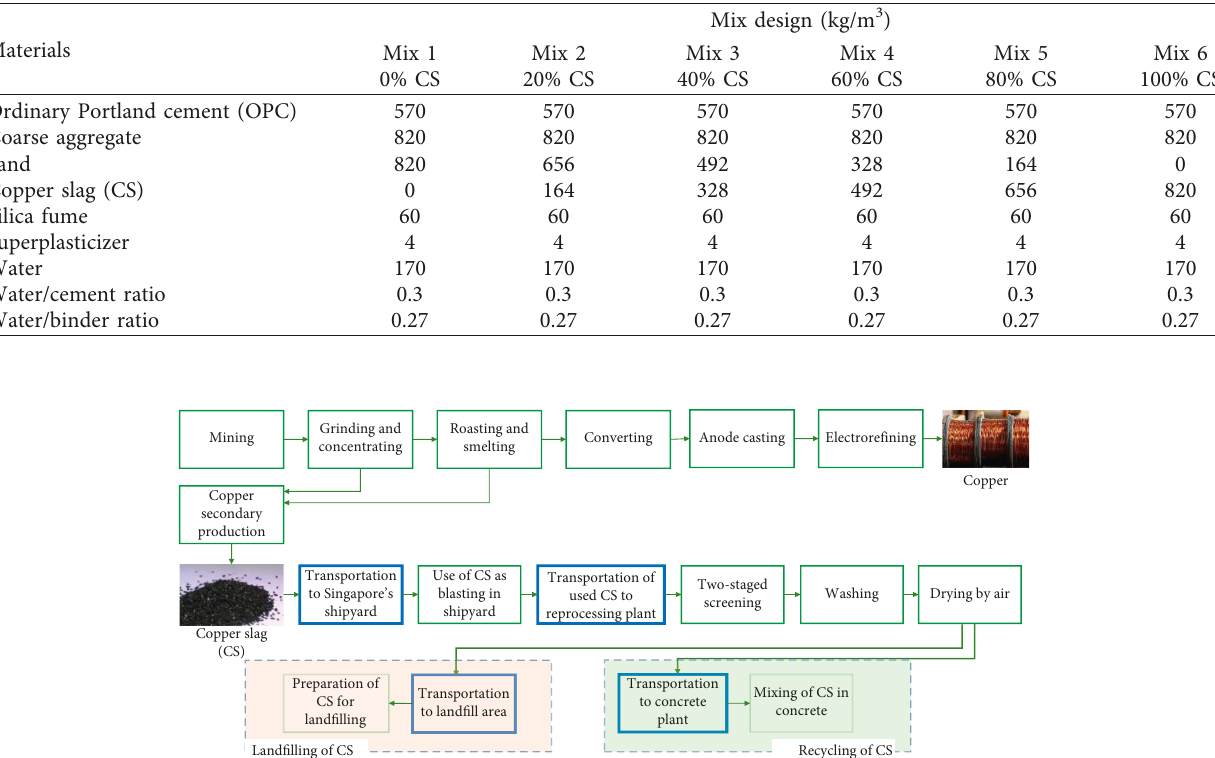
Table 2: Concrete mix design and proportions of